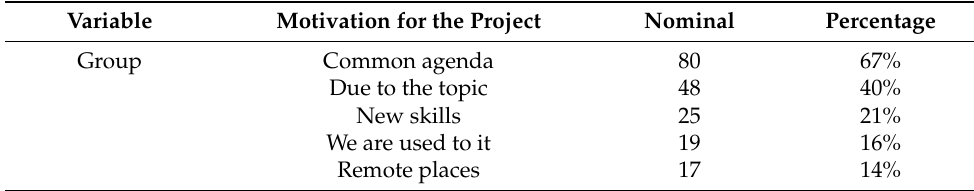
Table 18. Motivation for the